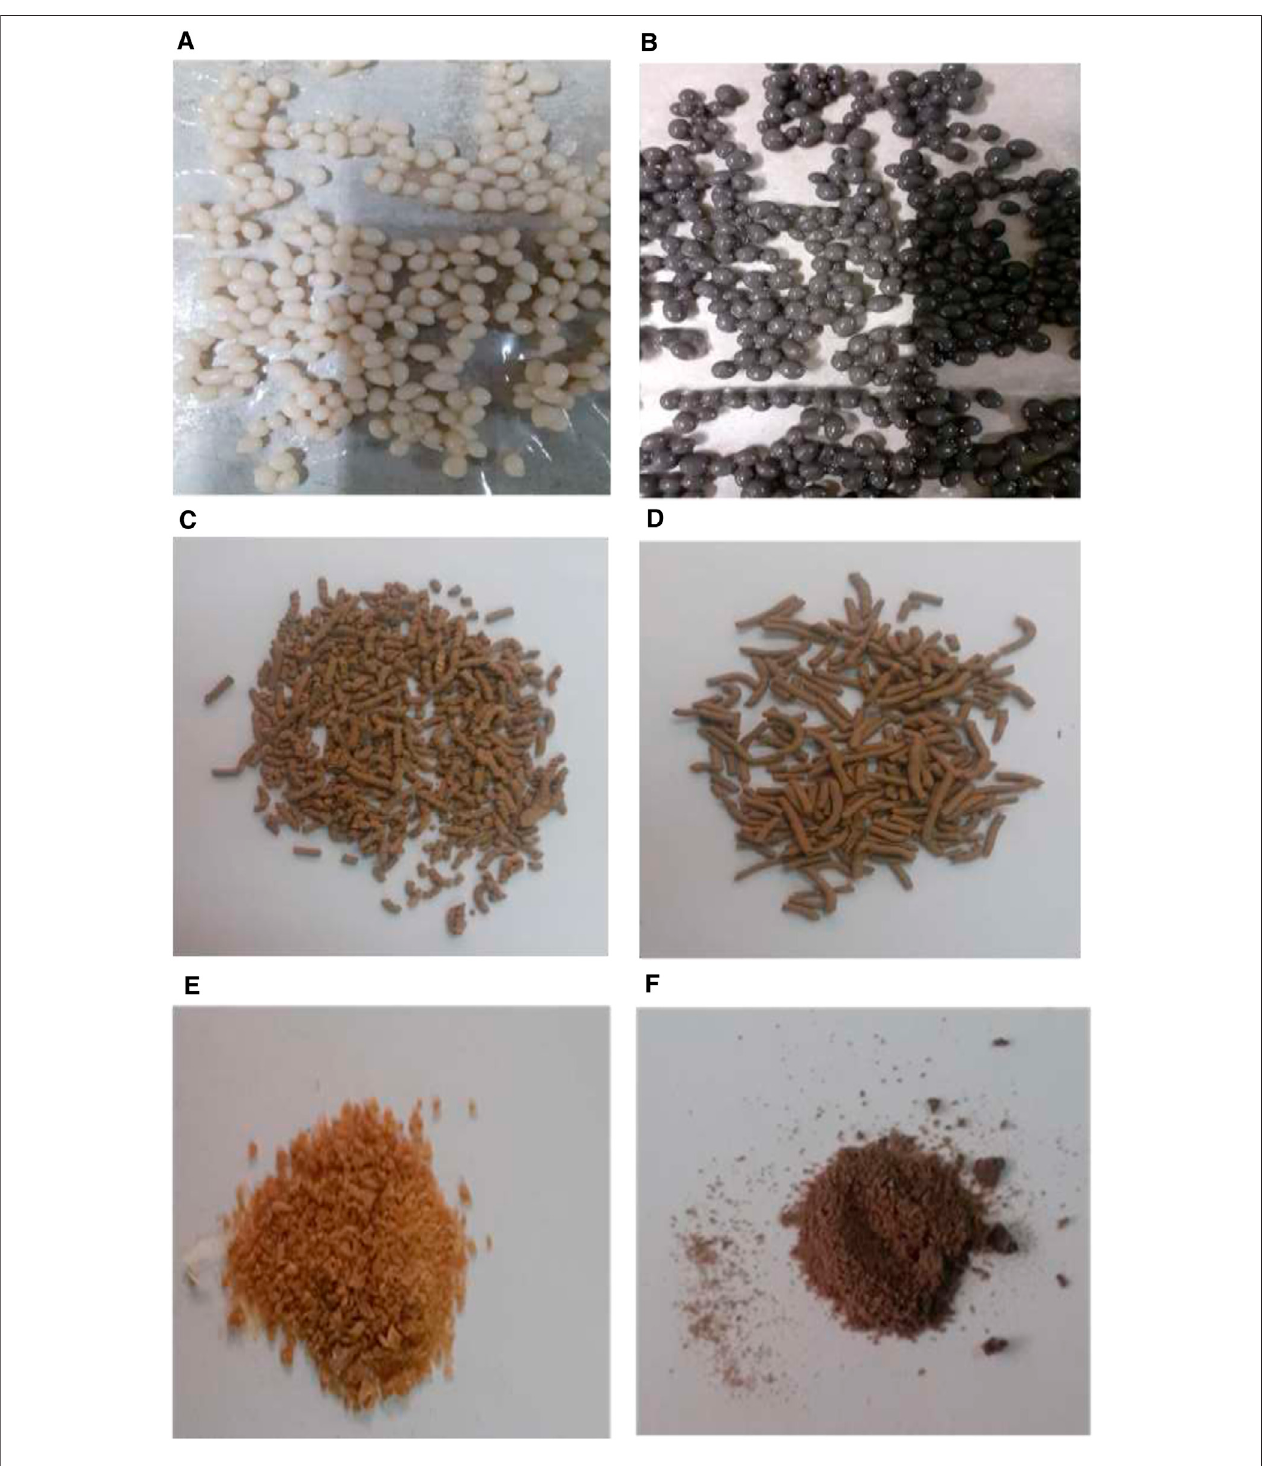
FIGURE 2 | Three types of bio-formulations of Pseudomonas sp. A3 + Bacillus amyloliquefaciens A9 and Aspergillus sydowii AK20. (1) Alginate – bentonite beads (A,B) . (2) Guargum – nanobentonite water-dispersible granules (WDG). (C,D) Carboxymethyl cellulose (CMC) – bentonite (E,F) . most of the cases, the values of correlation coef fi cient (r) were > 0.970. The half-life (t 1/2 ) of TPH in 1% (T1), 2% (T14), and 5% (T17) uninoculated soils was 69.7, 72.9, and 87.0 days, respectively. ( Table 2 , Figure 3 ). Data fi tted well to fi rst-order kinetics as in